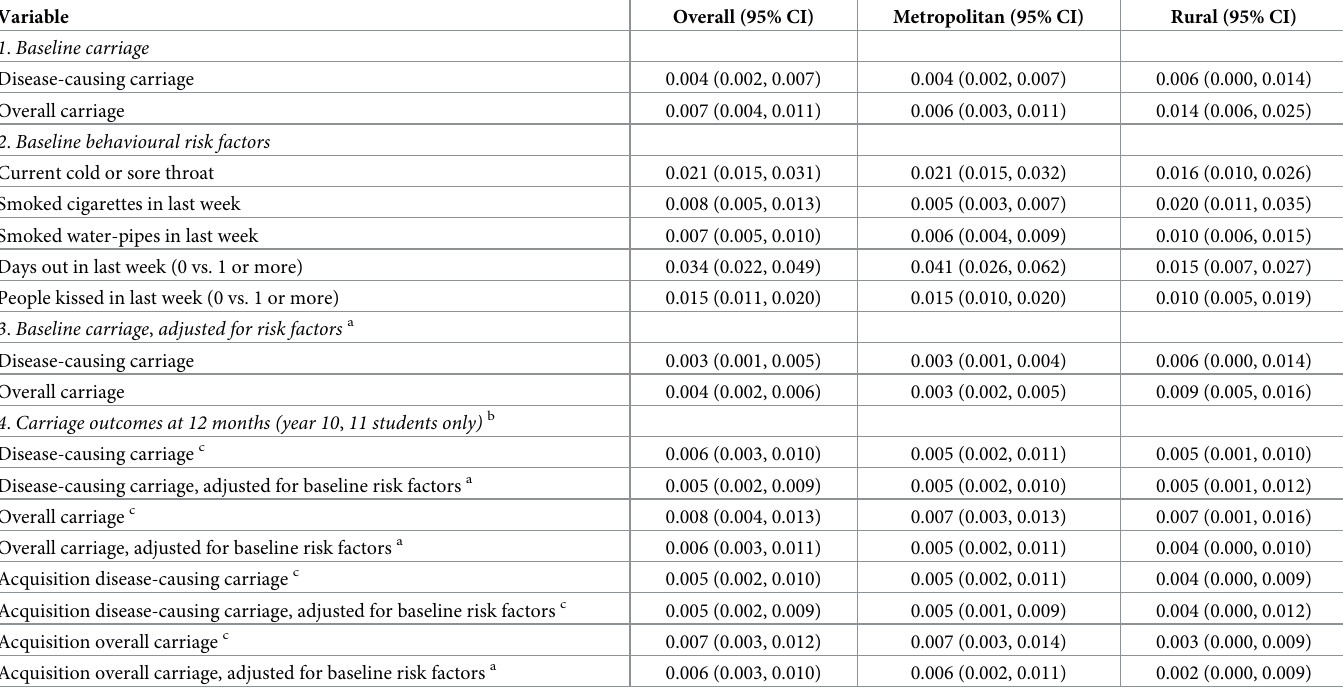
Table 2. Intracluster correlation coefficients for Nm carriage and behavioural risk factors, overall and by location at baseline and at 12 months.